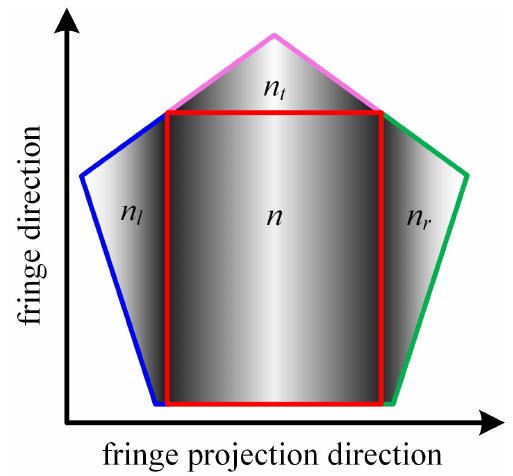
Figure 2. Partial sinusoidal fringe image acquired by